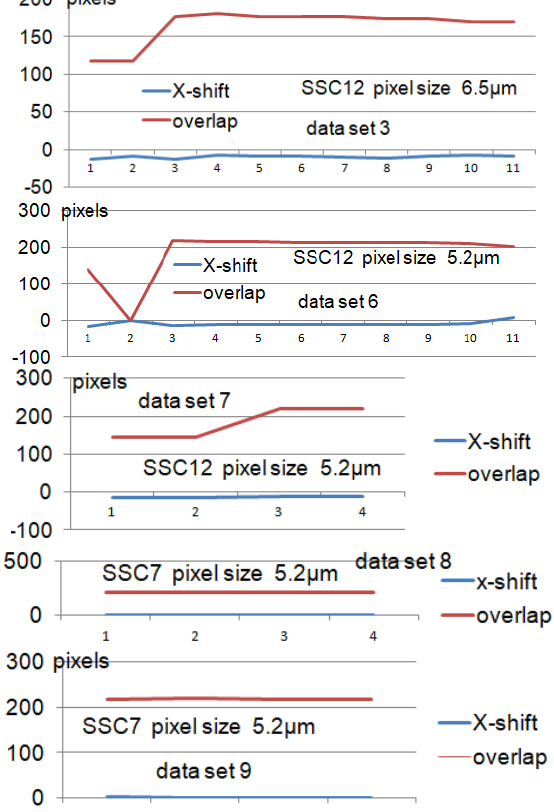
Figure 12: X-shift and overlap of adjacent Basic images in flight direction for the same frame, horizontal = sequence of images in Collect